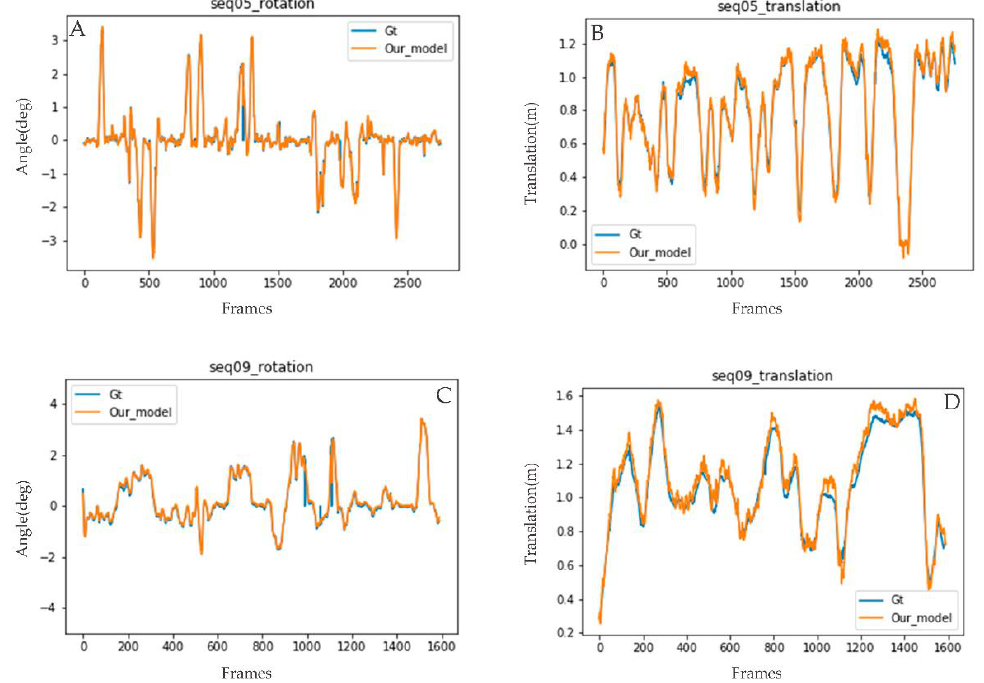
Figure 9. Results of our proposed method ’ s estimated translation and rotation plotted against the ground truth (results from KITTI 05 ( A , B ) and 09 ( C , D ) used as a sample).